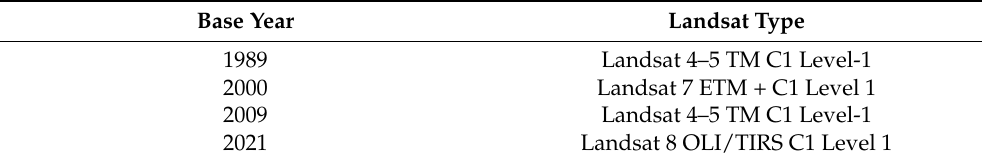
Table 3. Landsat images and years of